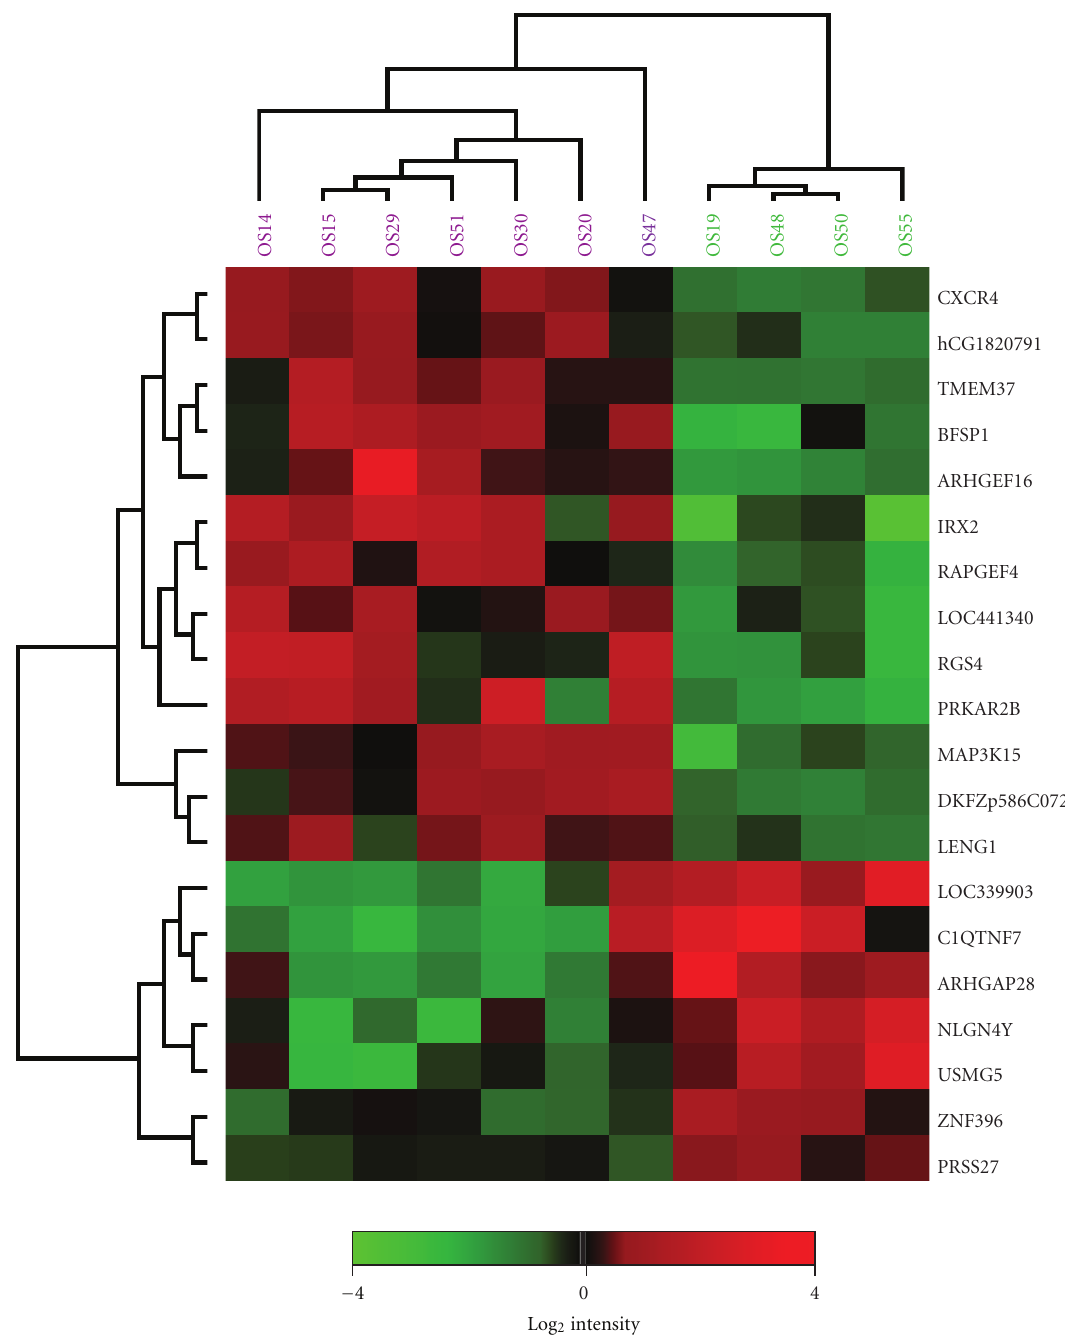
Figure 2: Hierarchical clustering of all primary tumours based on the top-20 significant genes di ff erentially expressed between primary samples from patients who developed metastases and those who did not, identified by SAM analysis (one primary tumour with no clinical information on metastases was excluded). Samples coloured in lilac, primary samples from patients who later developed metastases; green, primary samples from patients who did not develop metastases. Red, increased gene expression; green, decreased gene expression. The cluster was made using average linkage and Pearson’s